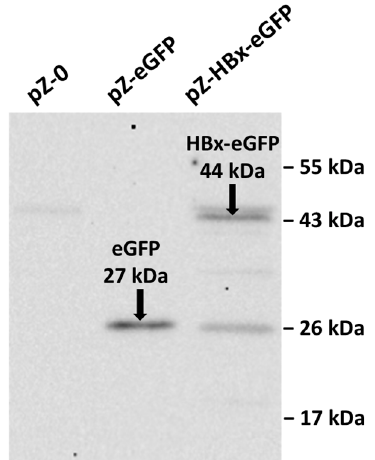
Figure 1. Western blot analysis of eGFP fusion proteins from pZ-0, pZ-eGFP, and pZ-HBx-eGFP strains of Y. lipolytica . The eGFP and HBx-eGFP signals are indicated by arrows. On the right, the molecular weights of the markers are shown.